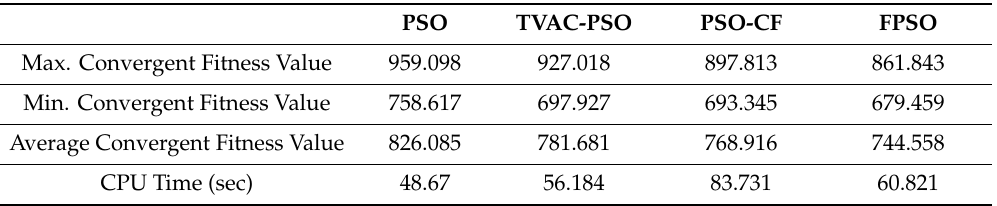
Table 5. The comparison of PSO, TVAC-PSO, PSO-CF, and FPSO in Case